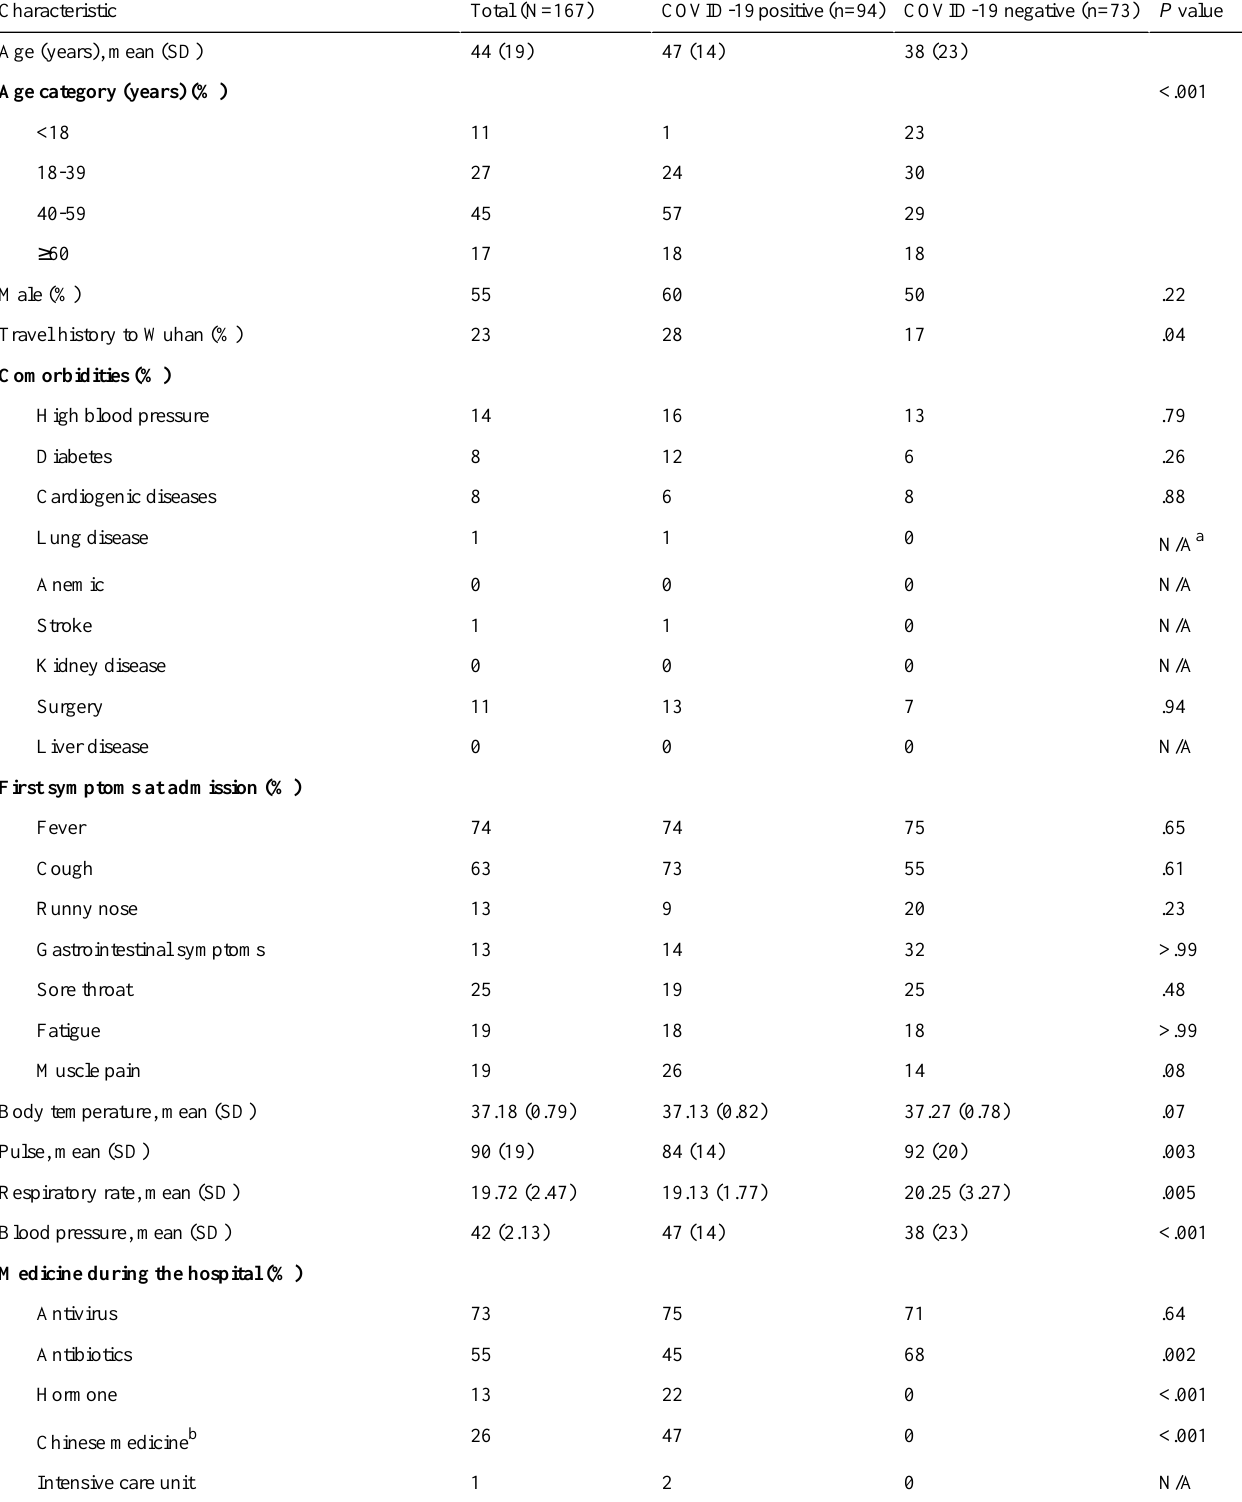
Table 1. Epidemiological characteristics of suspected cases of COVID-19.